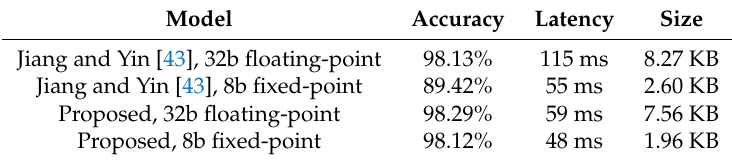
Table 5. Implementation results of DCNN operations at the prototype EPTS